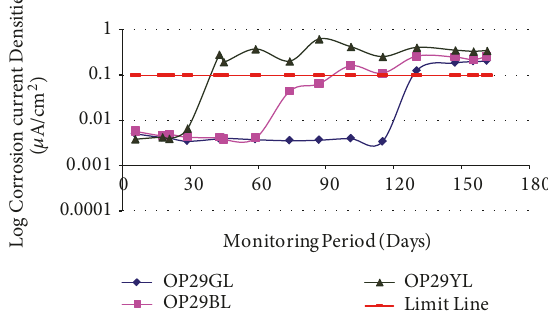
Figure 2: Log corrosion current densities versus time for PCDC at w/c 0.85.